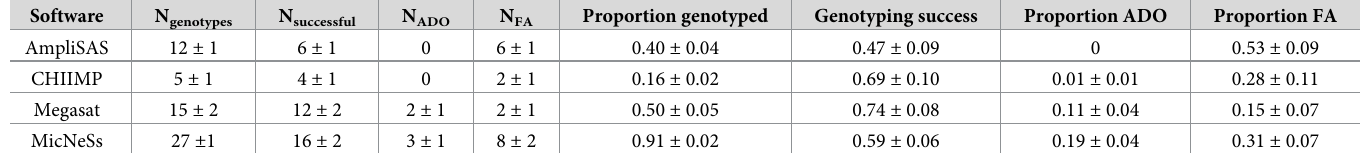
Table 2. Genotyping error rates among software packages with default settings. Default minimum read depth; AmpliSAS, 100 reads; Megasat, 50 reads; CHIIMP, 500 reads; MicNeSs, 16 reads. Proportion genotyped , the number of genotypes estimated by each software ( N genotypes ) divided by the total number of reference genotypes per locus across all replicates and samples. Genotyping success , the number of genotypes that coincide with the consensus ( N estimated by the software per locus across all replicates and samples ( N genotypes ). Proportion ADO , the number of heterozygote genotypes for which only one of the two alleles could be genotyped ( N ) divided by the number of heterozygote genotypes in the reference. Proportion FA , the number of genotypes including a false allele ( N ADO divided by the total number of reference genotypes. Values are shown as mean ± standard error per